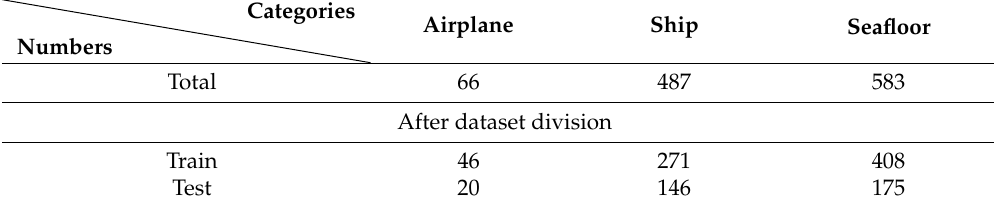
Table 1. Division situation of SeabedObjects-KLSG-II dataset.